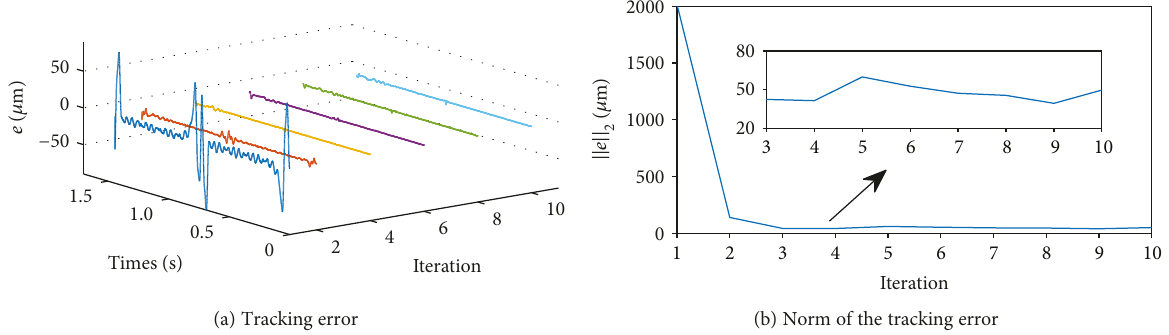
Figure 10: Convergence of the proposed algorithm under α = 29 .